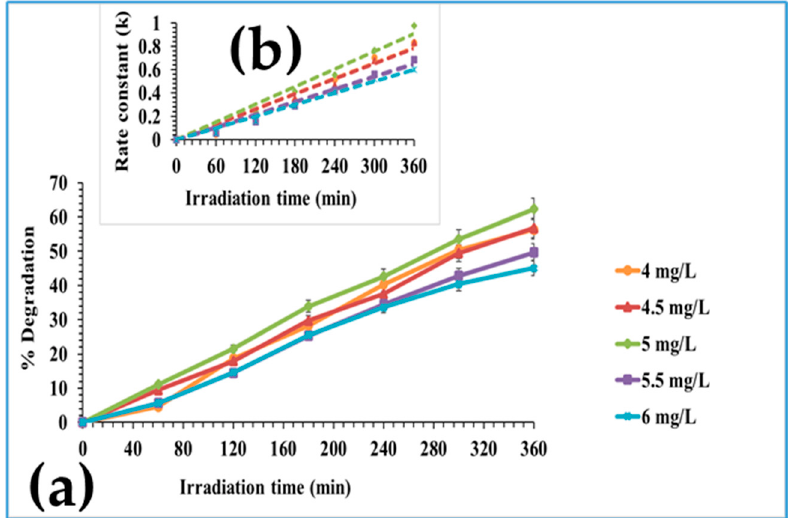
Figure 16. ( a ) Photocatalytic degradation performance efficiency of ~5 mg Mo/HRTiO 2 ceramic sup- ported photocatalyst over the degradation of 4, 4.5, 5, 5.5, and 6 mg/L initial IBU concentration under natural (unmodified) pH ~ 4 and 365 nm UV irradiation, and ( b ) their corresponding photocatalytic degradation rate constant (k).